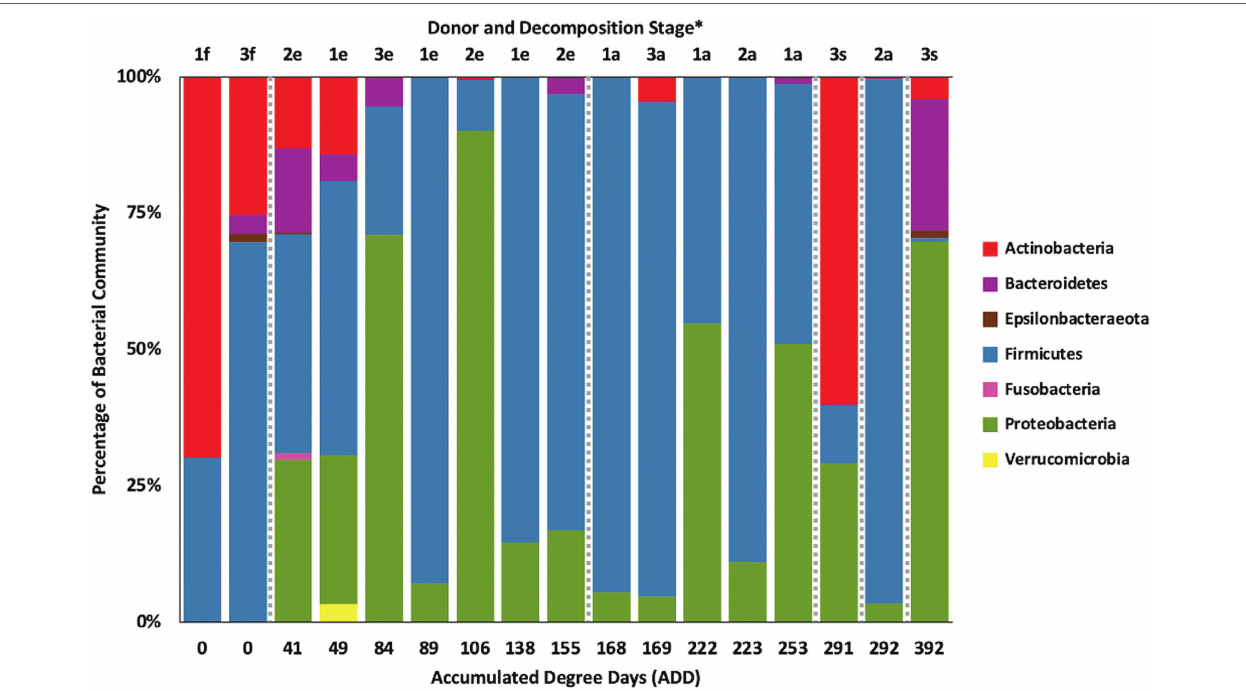
FIGURE 2 | Proportion of bacterial phyla determined from 16S rRNA gene sequencing of the V6–V8 hypervariable region from oral samples of three human donors (Donors 1, 2, and 3) during decomposition. Decomposition was assessed as ADD on the x -axis, and samples were also classified to an overall decomposition stage for each donor at each sampling event ( * f , fresh; e , early; a , advanced; and s ,